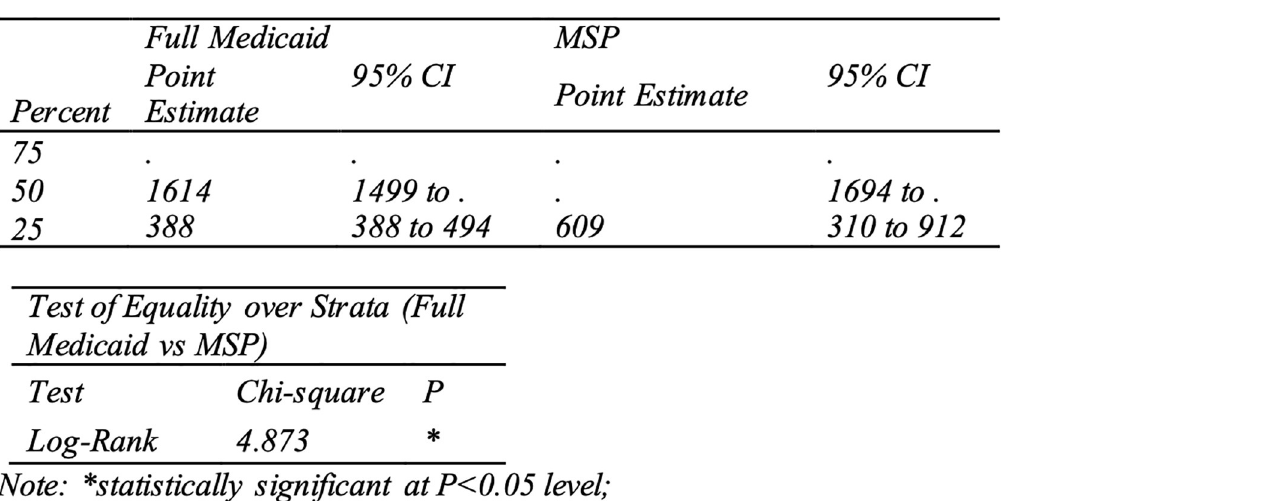
PLOS ONE | https://doi.org/10.1371/journal.pone.0250967 May 18,